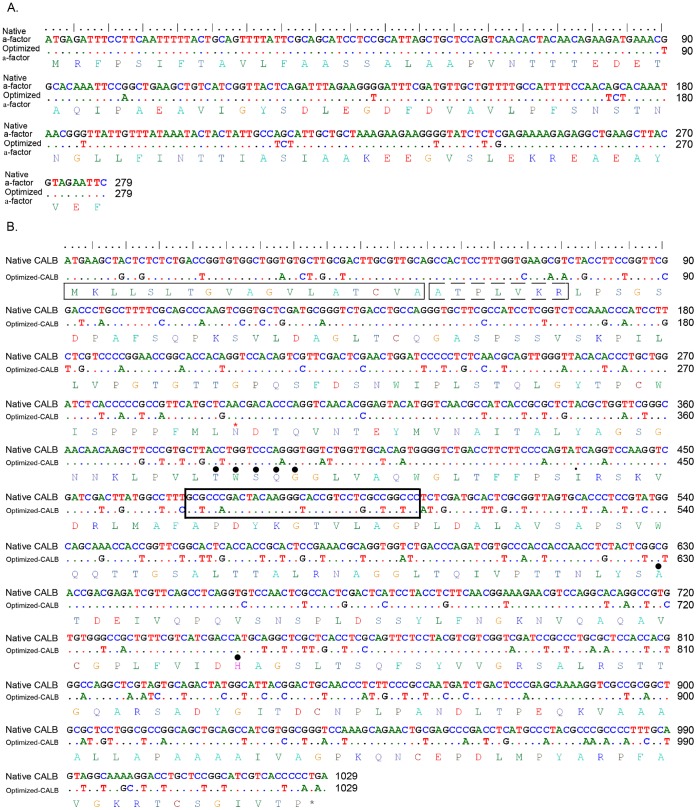
Sequence comparison between the native and codon-optimized genes.(A). α-factor; (B). CALB gene. Dots represent the same nucleotides between the native and codon-optimized genes. Solid line box and dash line box indicate the signal peptide and pre-sequence of CALB, respectively, and * indicates the possible glycosylation site. • indicate the catalytic triad Ser130–Asp210–His249 and the conserved penta-peptide motif TWS130QG. Bold solid line box indicate the link sequence of F1 and F2 fragments for OE-PCR.